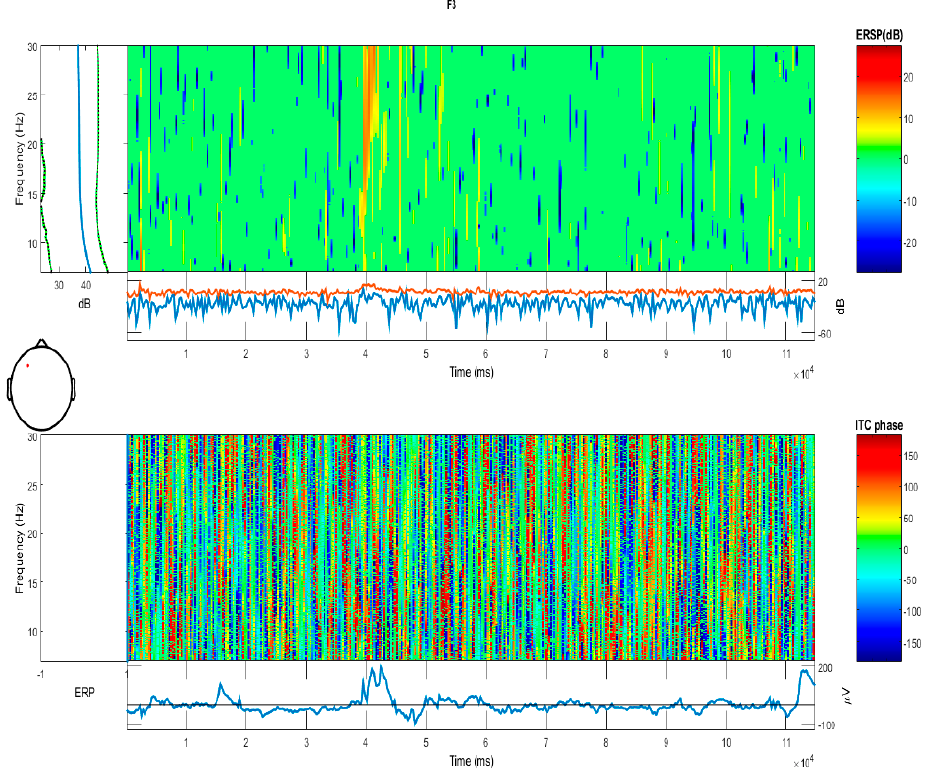
Figure 6. Brain activity of User A at point F3.